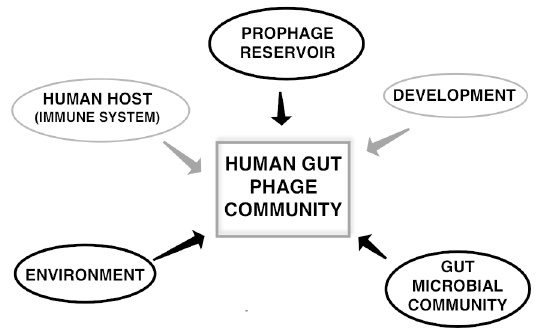
Figure 1. Major factors influencing the structure, function, and dynamics of the gut phage community. Factors that can influence the phage community and serve as a source of phages are marked in thick black circles. Factors that only influence the viral community composition are marked in grey.